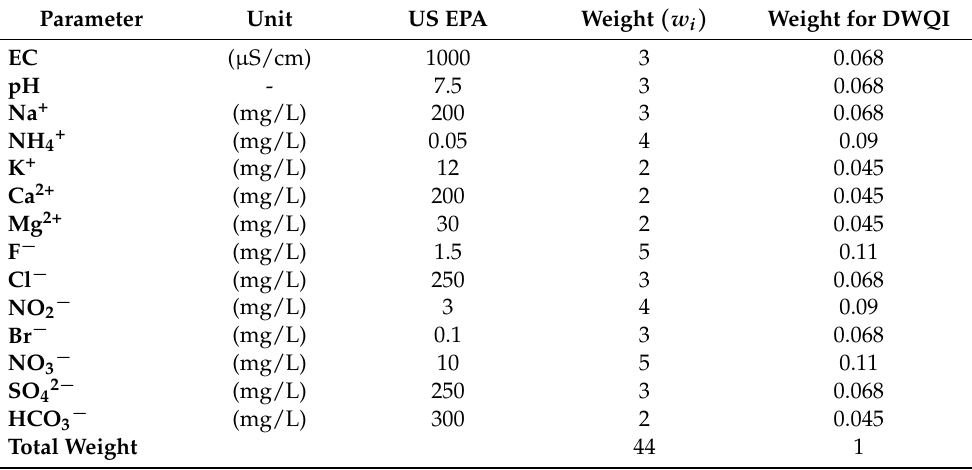
Table A1. Weight and relative weight of each parameter compared with US EPA standard.